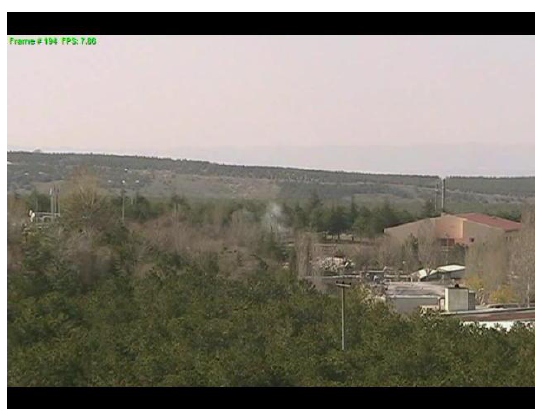
Figure 8. Some of video sequences used in evaluation of the proposed